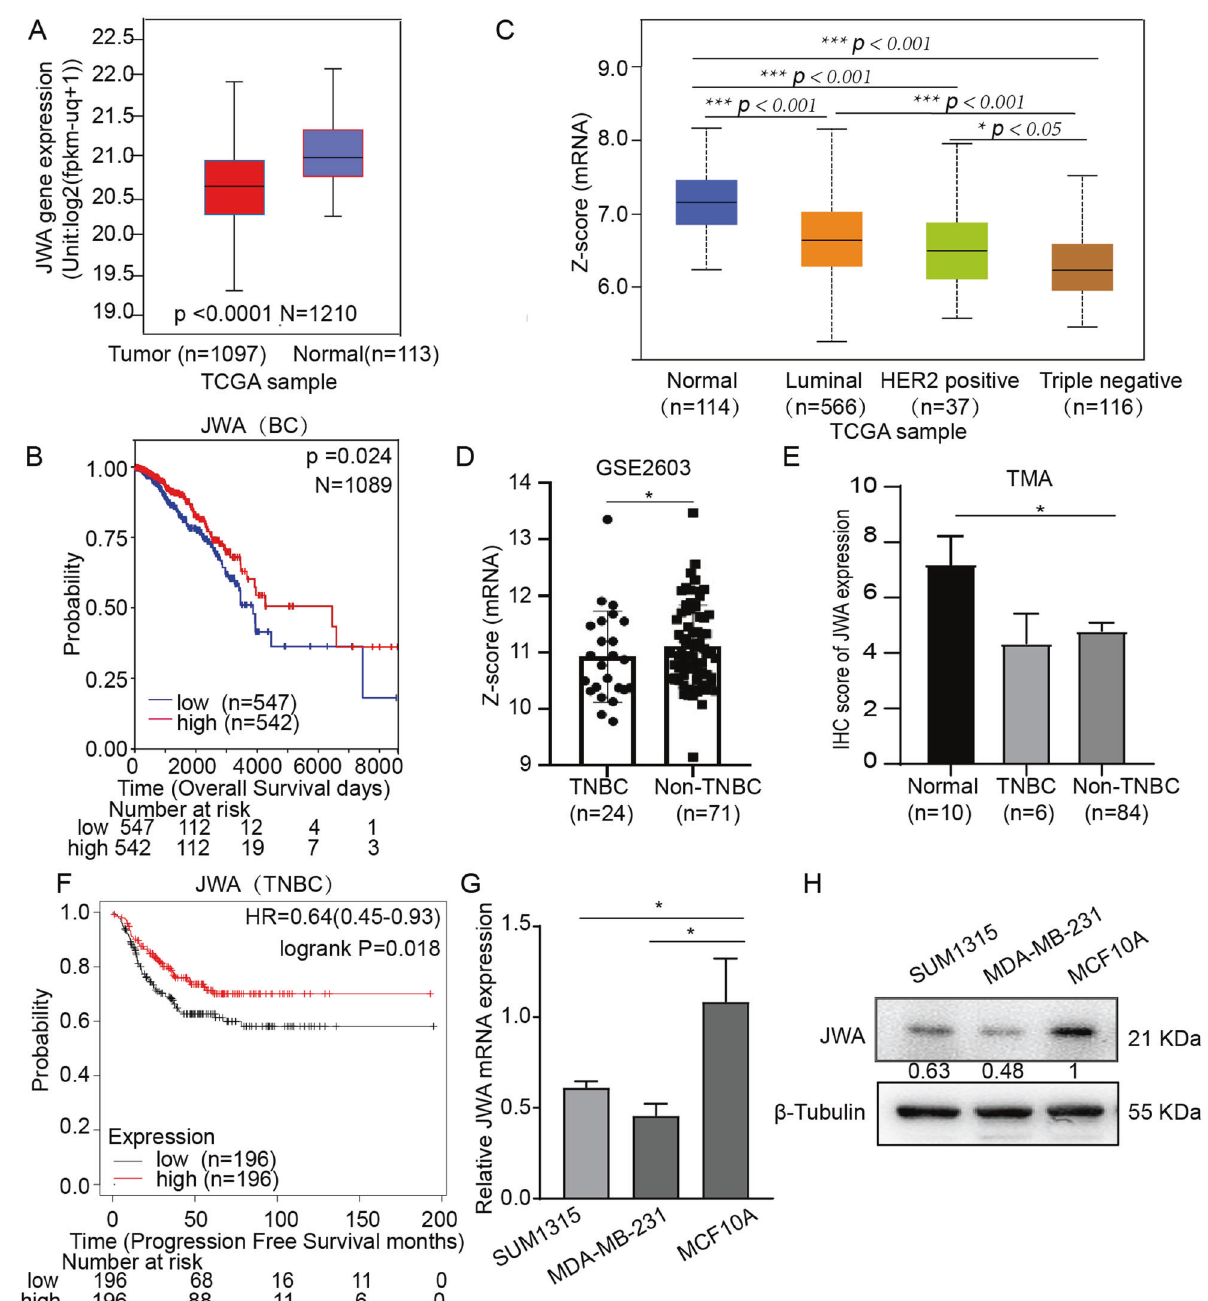
Fig. 1 Down regulation of JWA is associated with poor prognosis in TNBC. A JWA mRNA expression was interrogated in unpaired cohorts (TCGA database, 1097 cancer samples, 113 non-cancerous samples). B Kaplan – Meier curves depicted Overall Survival according to the JWA expression of breast cancer cohort ( n = 1089). C The JWA expression level was analyzed in subtypes of breast cancers. (TCGA database,114 normal; 566 Luminal; 37 HER2 positive; 116 Triple negative). D GSE2603 database was analyzed for JWA expression (24 TNBC; 71 non-TNBC). JWA mRNA level was compared between TNBC and non-TNBC. E The protein expression of JWA was compared between normal( n = 10), TNBC ( n = 6) and non-TNBC ( n = 84) tissues. F Kaplan – Meier curves depicted progression-free survival according to the expression of JWA in TNBC cohort. P values were calculated with the log-rank test. G The mRNA expression of JWA in normal breast cell (MCF10A) and TNBC (MDA-MB- 231 and SUM 1315) cells ( n = 3). H The protein expression of JWA in normal breast cell (MCF10A) and TNBC (MDA-MB-231 and SUM1315) cells. Z-score = log 2 (FPKM + 1) . * P < 0.05, ** P < 0.01, *** P < 0.001, **** P < Progression-Free-Survival (PFS) of TNBC patients was positively that the mRNA expression of JWA in TNBC tissues was lower than correlated with the mRNA expression levels of JWA (https:// that in non-TNBC tissues (Fig. 1D). In protein level, the expression kmplot.com/analysis/) ( P < 0.05, Fig. 1F). For further mechanistic of JWA was also downregulated in both TNBC and non-TNBC investigation of how JWA involves in TNBC development, we tissues compared with its adjacent normal tissues ( P < 0.05, detected both the mRNA and protein expressions of JWA in Fig. 1E). The results from TCGA database also showed that